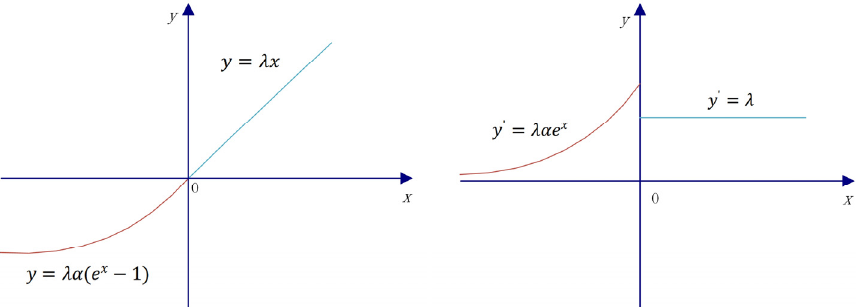
Figure 4. The SELU activation function and its derivatives.